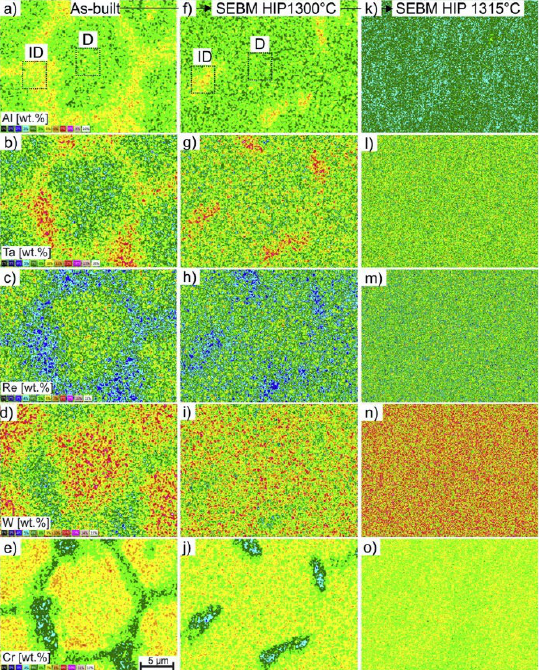
Figure 23. EDS element mappings of the SEBM material in the as-built state ( a – e ) and after two ( f – j , k – o ) different subsequent HIP treatments [67] .